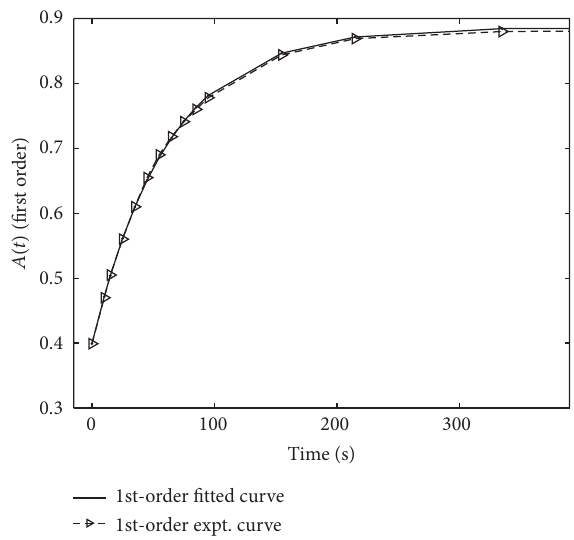
Figure2:Plotoftheexperimentalandcurvewithoptimizedparam- etersshowingtheveryclosefitbetweenthetwo.Theslightdifference between the two can probably be attributed to experimental